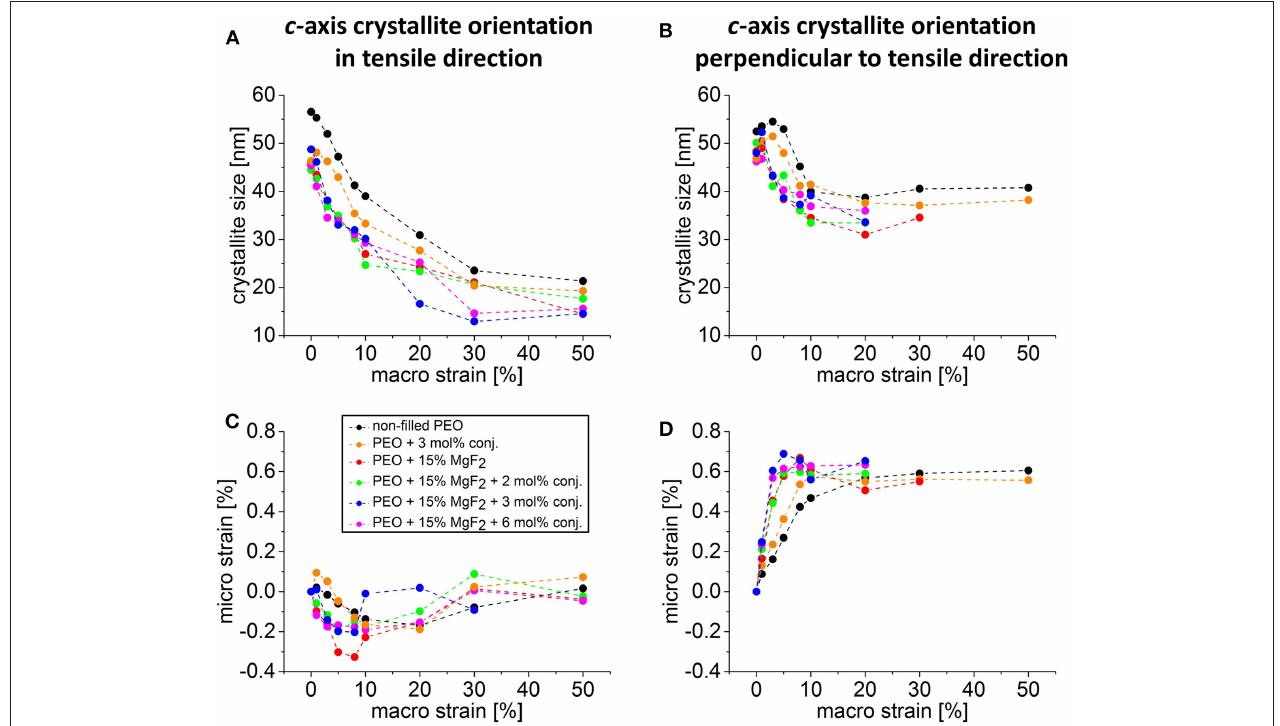
FIGURE 5 | Plots of crystallite sizes vs. macro strain with c-axis crystallite orientation (A) in and (B) perpendicular to the tensile direction of exemplary sample compositions. The crystallite size changes to lower sizes after MgF 2 and conjugate insertion and with increasing macro strain. Major changes of the crystallite sizes can be seen with increasing macro strain with the c-axis crystallite orientation in tensile direction. The applied micro vs. macro strain is drawn with the c-axis crystallite orientation (C) in tensile direction and (D) perpendicular to the tensile direction. With increasing macro strain the micro strain showed negative values for the c-axis crystallite orientation in tensile direction and increasing positive values up to a plateau perpendicular to the tensile direction. Dotted lines in the graph are shown to aid the